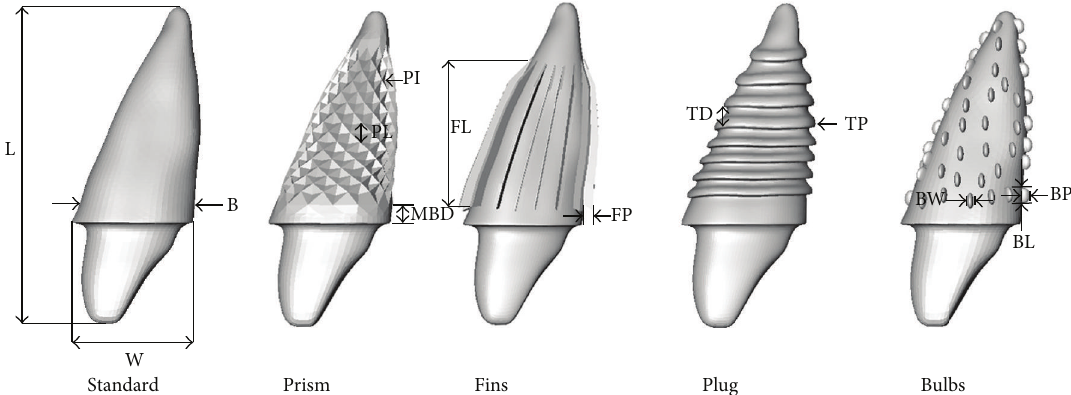
Figure 2: 3D models of the 5 designs analyzed. Dimensions and notation of geometric properties are as follows: L: total implant length 26.90 mm similar to all designs, W: maximum width of basic implant body 9.55 mm, MBD: shoulder margin to bone (B) distance 2mm for all models, PI: Prism maximum intrusion 0.85 mm, PL: Prism maximum length 1.65 mm, FP: Fins protrusion 0.80 mm, FL: Fins length 12.90 mm, TP: thread protrusion0.30 mm, TD: thread maximum distance 1.50mm, BP: Bulbs protrusion0.50 mm, BW: Bulbswidth 0.55 mm, and Bl: Bulbs length 1.20 mm.